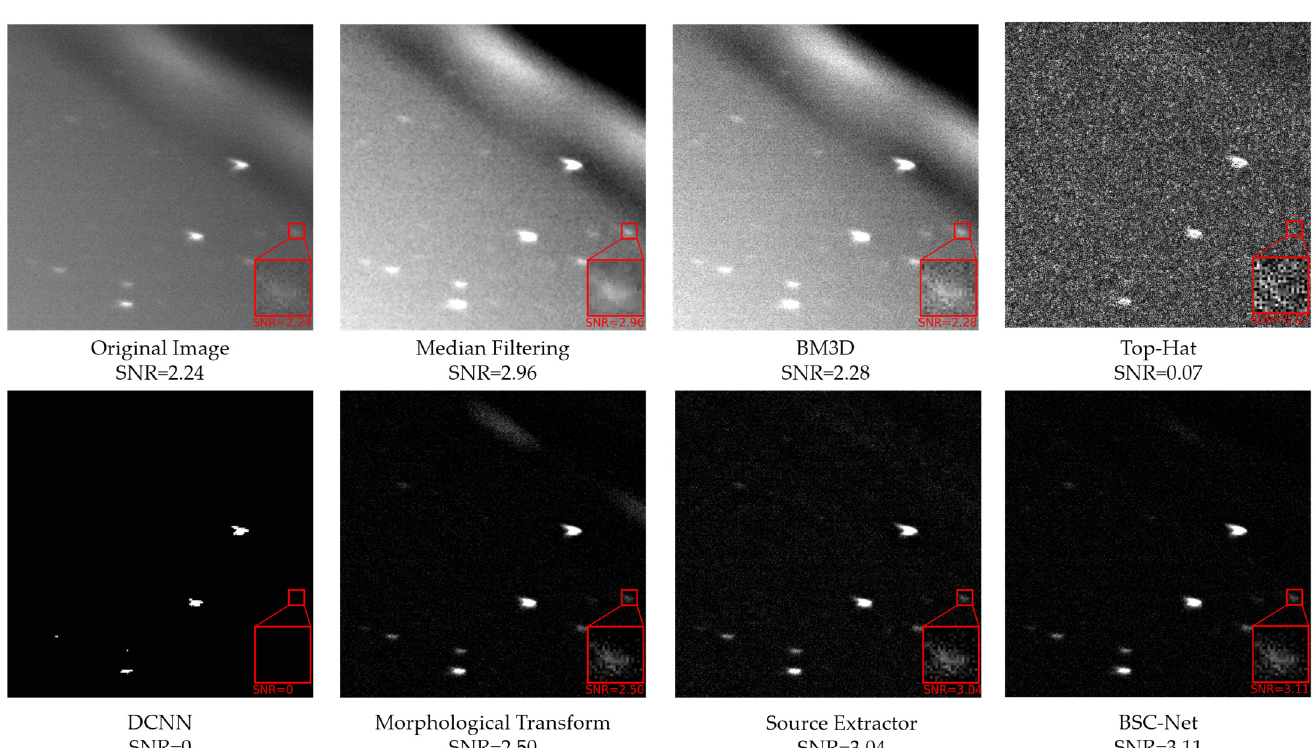
Figure 12. Results of clouds occlusion stray light in different algorithms (RMS = 205.97).